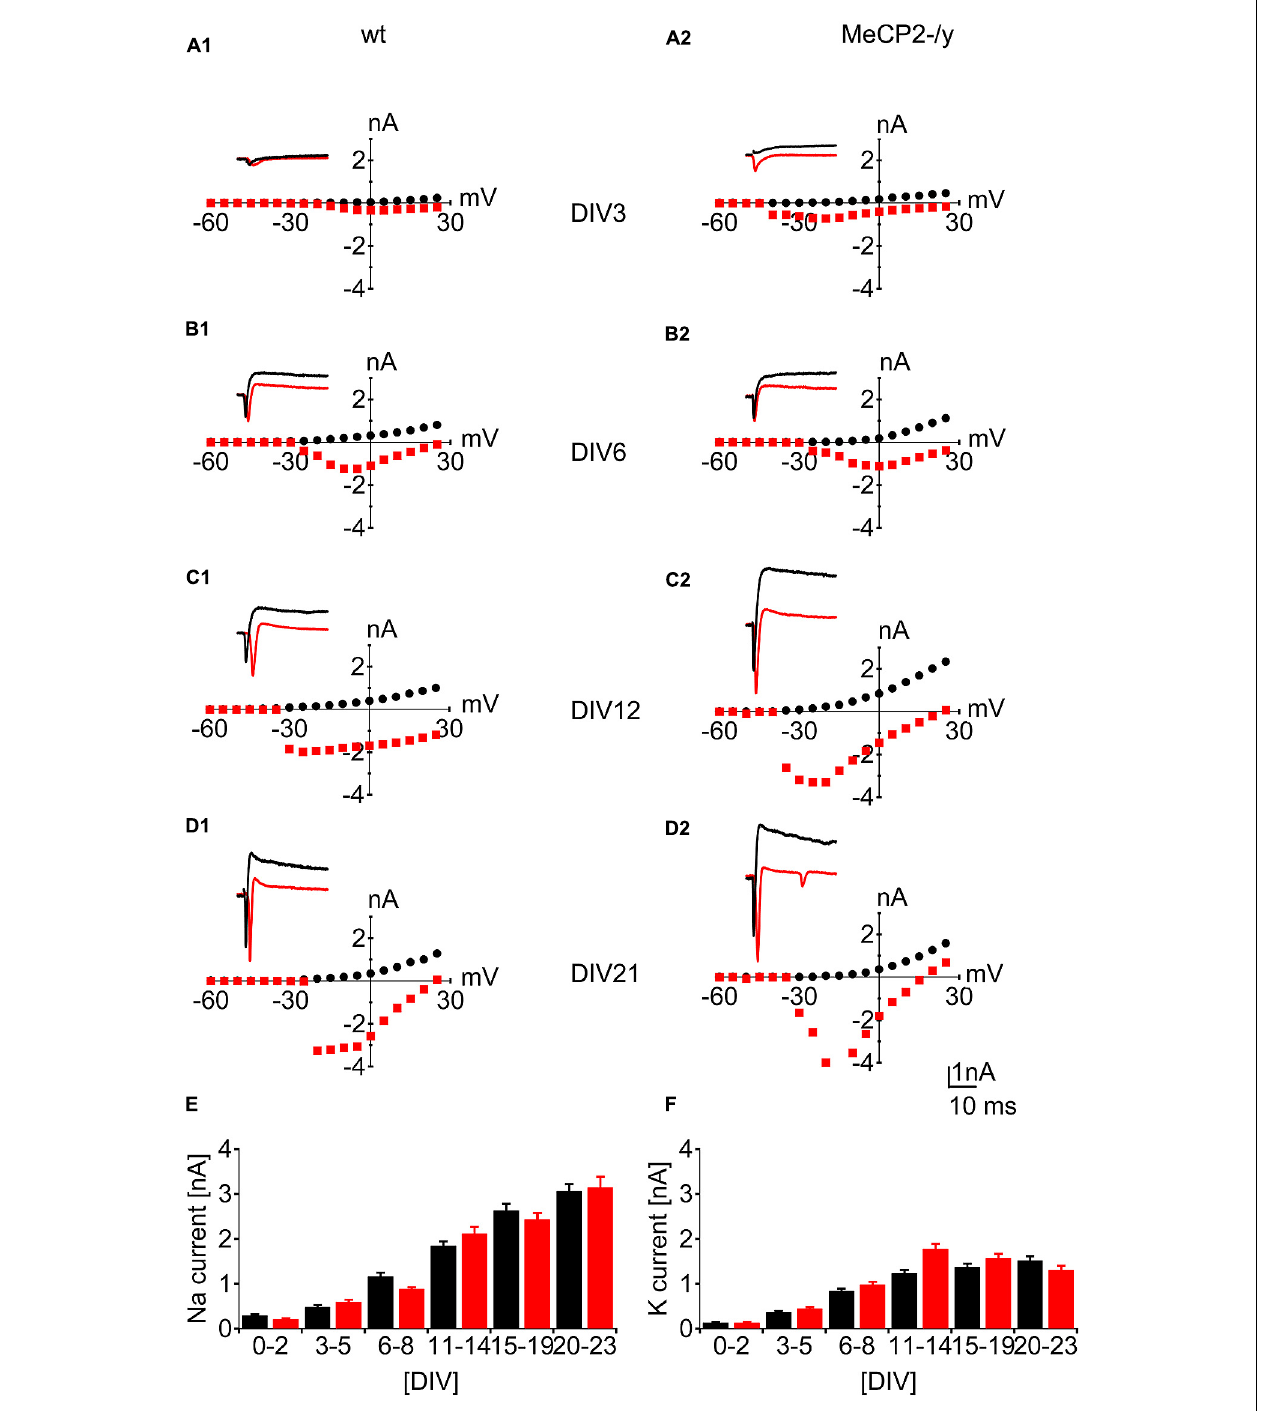
FIGURE 2 | Developmental characterization of voltage-gated sodium- and potassium currents. Sample traces and I–V curves for voltage activated inward sodium currents (red) and voltage activated outward potassium currents (black). Data points for the I–V curves plot peak inward current (red squares) against the holding potential after depolarization and the sustained outward current (black dots) against the